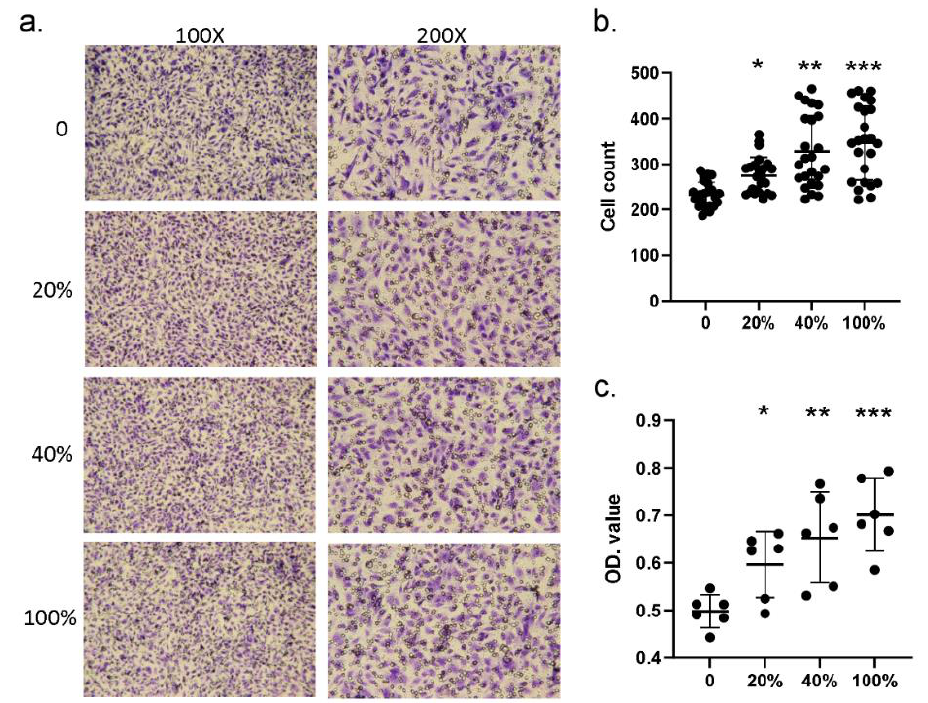
Figure 4. Trans-well assay showed that S100A4 promoted the migration of HCAECs. We used a trans-well kit to examine whether S100A4 affected the migration ability of HCAECs. ( a ) With the treatment of different S100A4 dosages, 45 pg/mL (20% of the average concentration on CAL+KD subjects), 90 pg/mL (40%), 180 pg/mL (80%), and 225 pg/mL (100%), HCAECs were subjected to a migration ability examination with a trans-well kit. ( b ) The HCAECs penetrating the insert membrane were quantified by staining and counting (three rounds * eight replications). ( c ) The cells were quantified by staining and measuring the OD values (three rounds * two replications). Data were presented as mean ± SD. *, ** and *** with a denoted p -value < 0.05, 0.01, and 0.001, respectively.